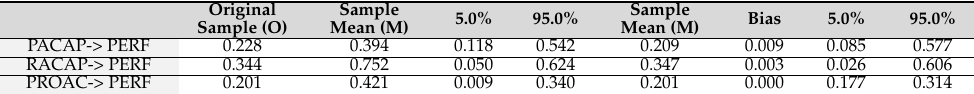
Table 5. HTMT inference.